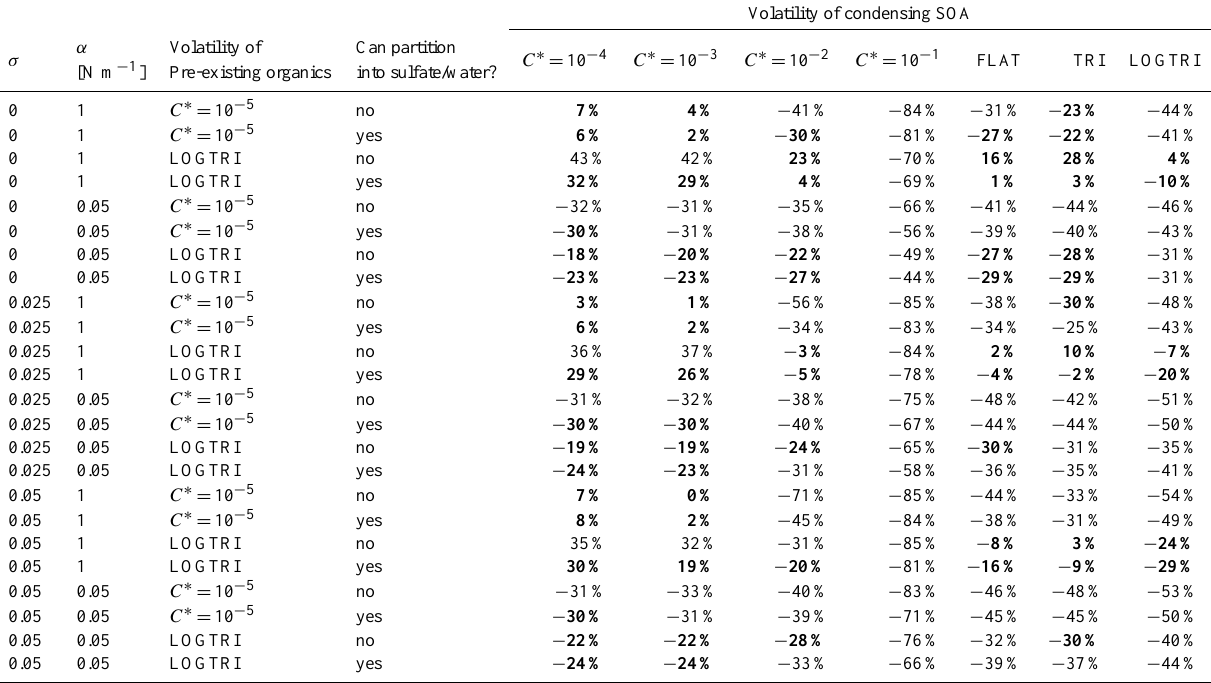
Table 3. Mean bias (%) across the 7 Hyyti¨al¨a and Egbert events for the various simulation assumptions. Mean biases less than ± 30% are shown in bold. The assumptions regarding the volatility distributions of freshly-formed secondary organic compounds are given by the different columns. Other model cases are varied in different